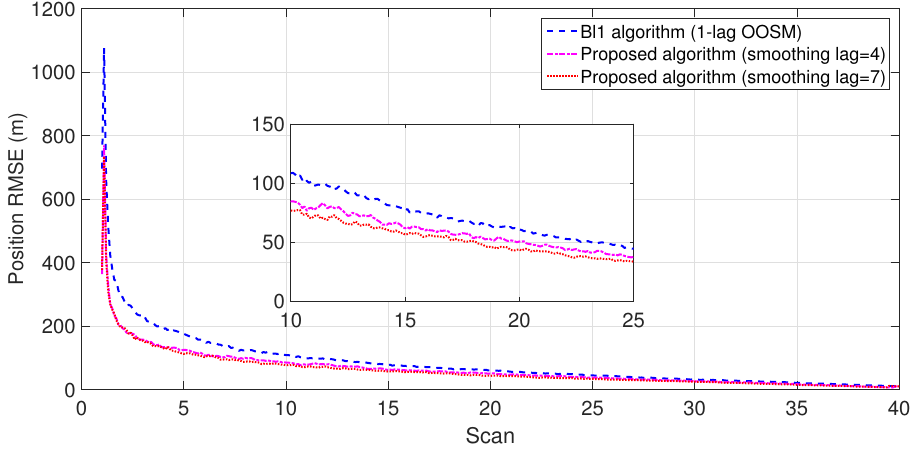
Bl1 algorithm (3-lag OOSM) Proposed algorithm (smoothing lag=4) Proposed algorithm (smoothing lag=7)